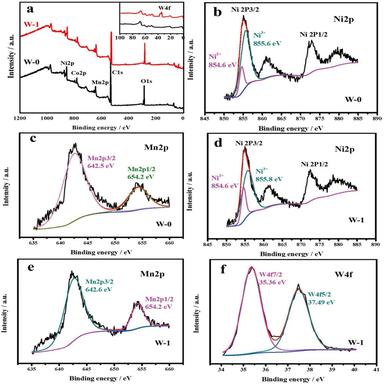
XPS spectra of pristine and modified LiNi0.6Co0.2Mn0.2O2 (a) full scan of the W-1 and W-0, (b) Ni 2p of the W-0, (c) Mn 2p of the W-0, (d) Ni 2p of the W− 1, (e) Mn 2p of the W-1 and (f) W 4 f of the W-1.